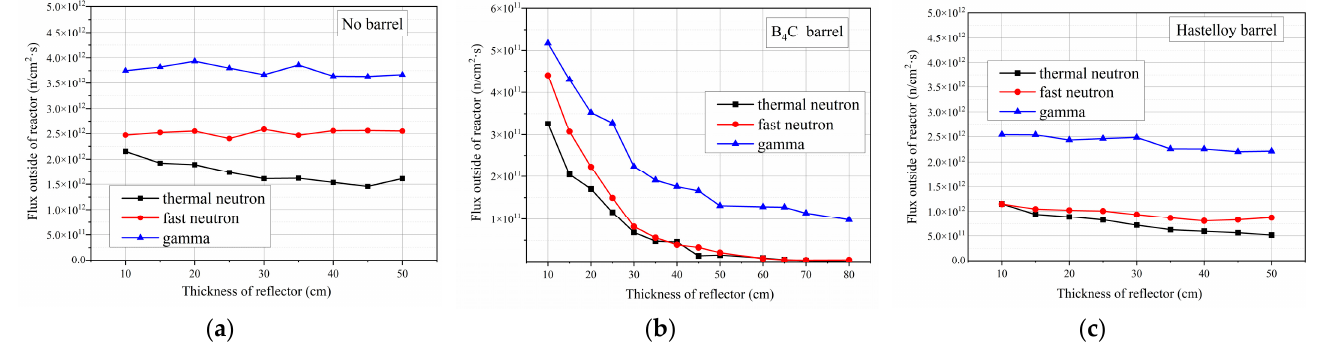
Figure 5. The fluxes in the inner surface of the main vessel varied with the reflector thickness: ( a ) scheme A without barrel; ( b ) scheme B with B 4 C barrel; ( c ) scheme C with Hastelloy barrel.